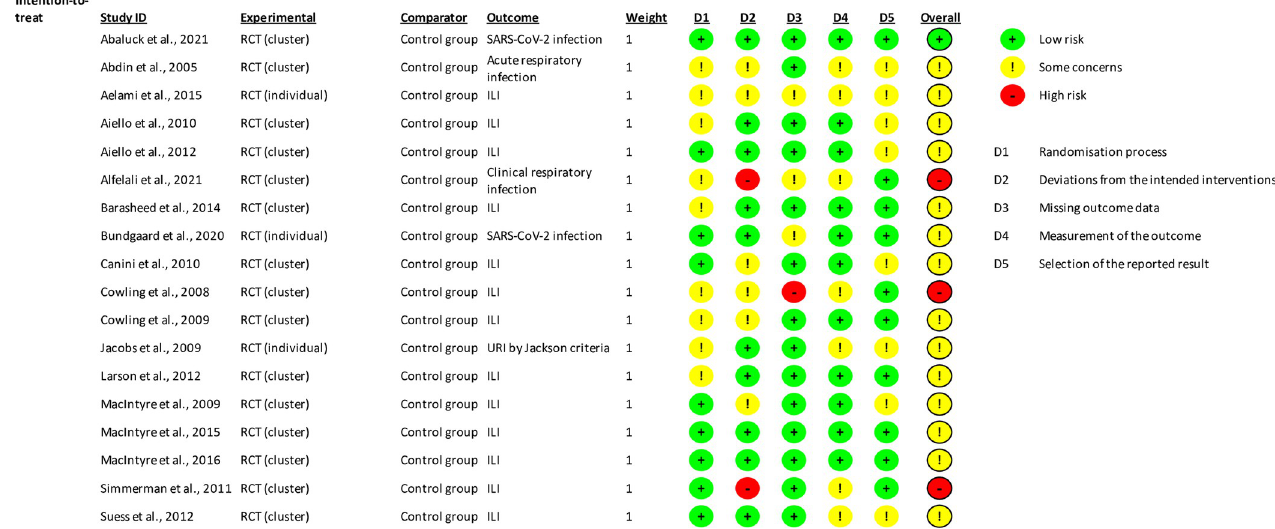
Fig 2. Risk of bias. Review authors’ judgement of each of the risk-of-bias item across the included studies evaluated using the Cochrane Risk of Bias 2 tool (ROB2).